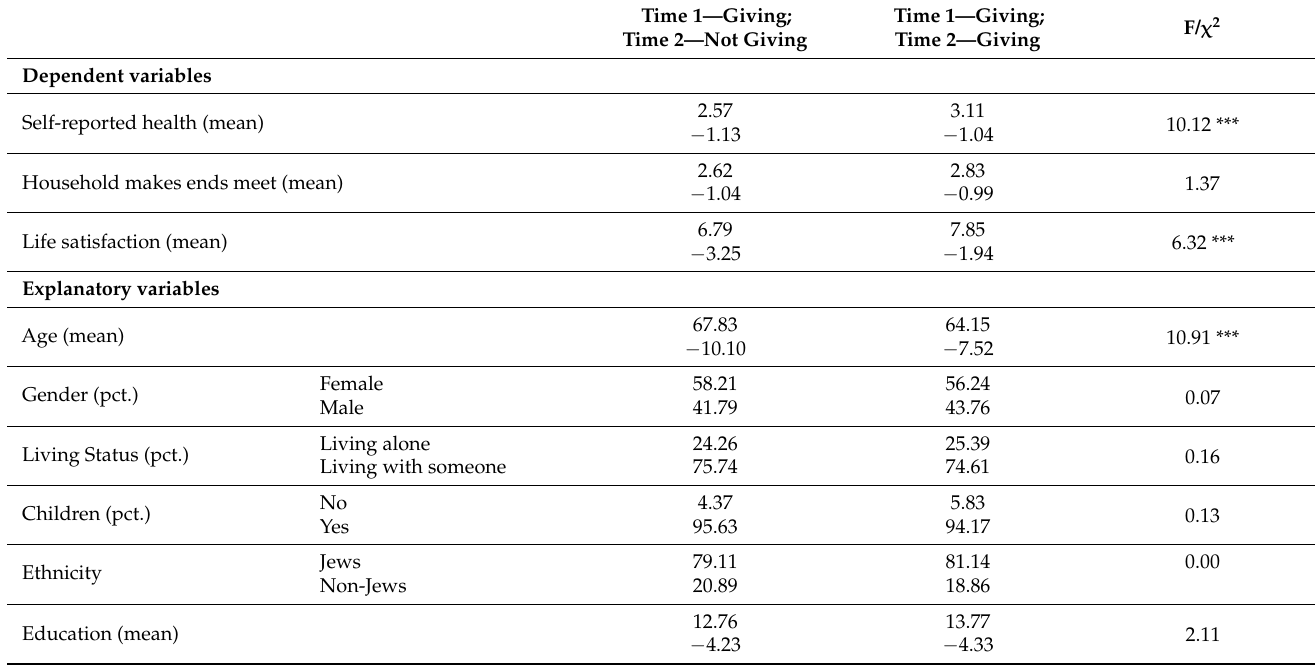
Table 2. Comparison of two carer groups—those who continued providing care, and those who ceased (means and percentages) 1,2